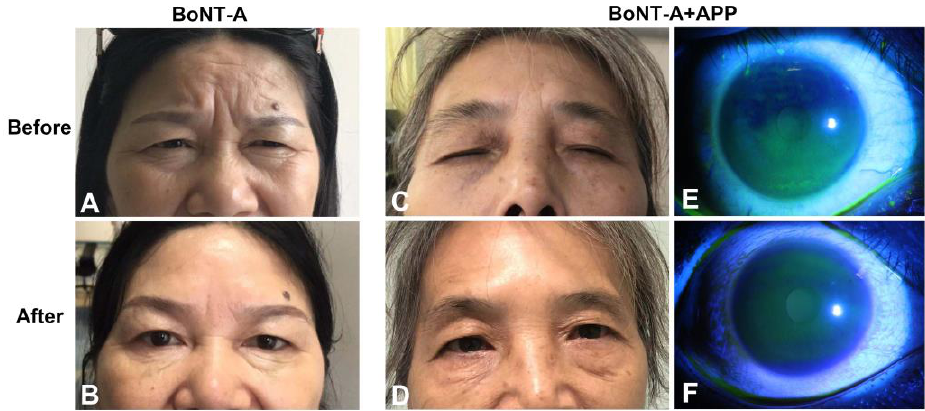
Figure 3. Typical manifestations of blepharospasm patients before and after treatment. ( A , B ) The facial characteristics before and after BoNT-A injection. ( C , D ) The facial characteristics before and after the combined treatment of BoNT-A and APP. ( E , F ) Corneal fluorescein staining before and after BoNT-A+APP combined treatment.